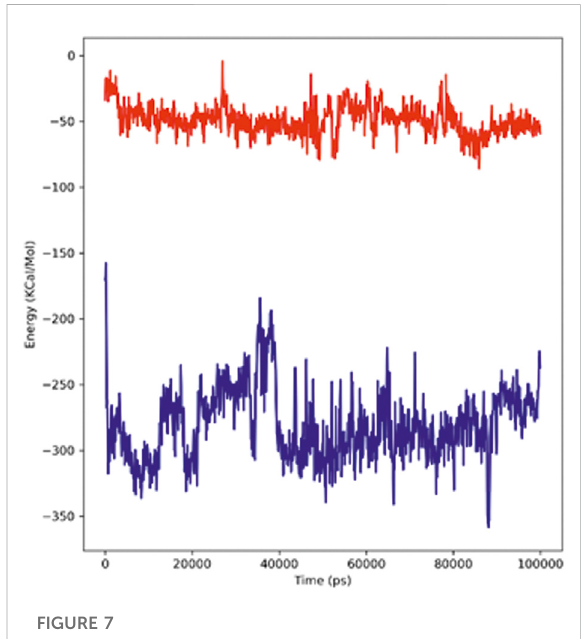
FIGURE 7 Plot representing theinteractions inthe form offree energies of binding between two complexes, adapalene (red) and tamsulosin (blue).